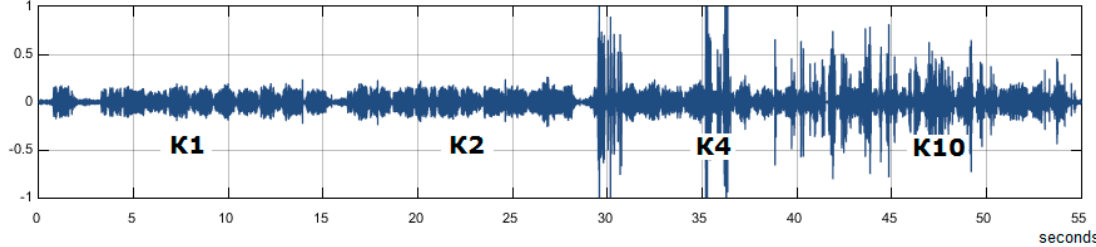
Figure 6. Time diagrams of the recorded signals on the 25 km distance.